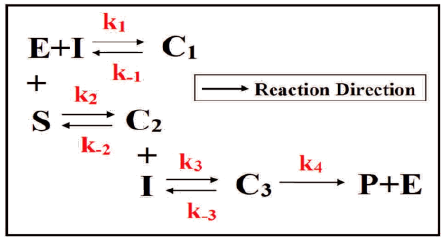
Figure 2. The schematic diagram of competitive inhibition